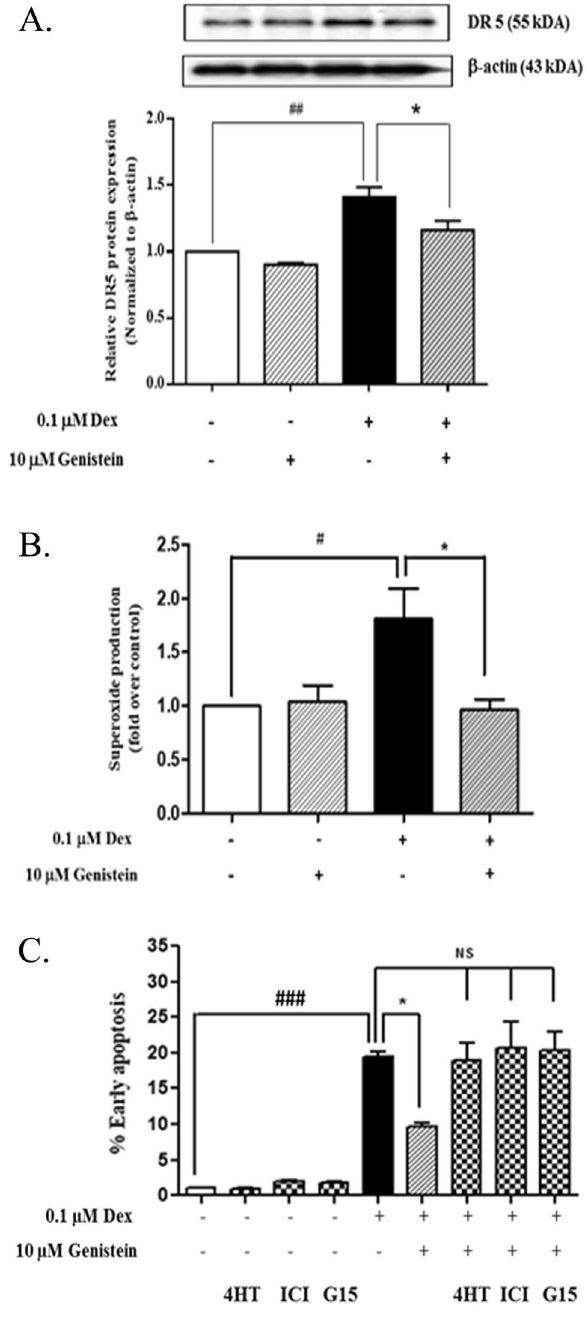
Figure 3. Effect of genistein on dexamethasone on DR5 expression in mouse isolated islets and on oxidative stress in INS-1 cell line. INS-1 cells and isolated mouse islets were treated with DMSO control or 0.1 μM dexamethasone with or without 10 μM genistein for 48 h. ( A ) A representative Western blot analysis of DR5 normalized to β-actin protein in mouse isolated islets. All bands were cropped and full-length blots are shown in supplementary Fig. 7. ( B ) Cellular superoxide production was determined by NBT assay. ( C ) A representative of AnnexinV/PI dot plot of the effect of dexamethasone and with or without 10 μM genistein in the presence or absence of estrogen receptors inhibitors including, estrogen α receptor inhibitor (4HT), estrogen α and β receptor inhibitor (ICI) or estrogen membrane receptor inhibitor (G15) for 72 h. Data are expressed as mean ± SEM of 3–4 independent experiments. ###, P < 0.001 versus control, ##, P < 0.001 versus control, #, P < 0.05 versus control; *, P < 0.05 versus 0.1 µM